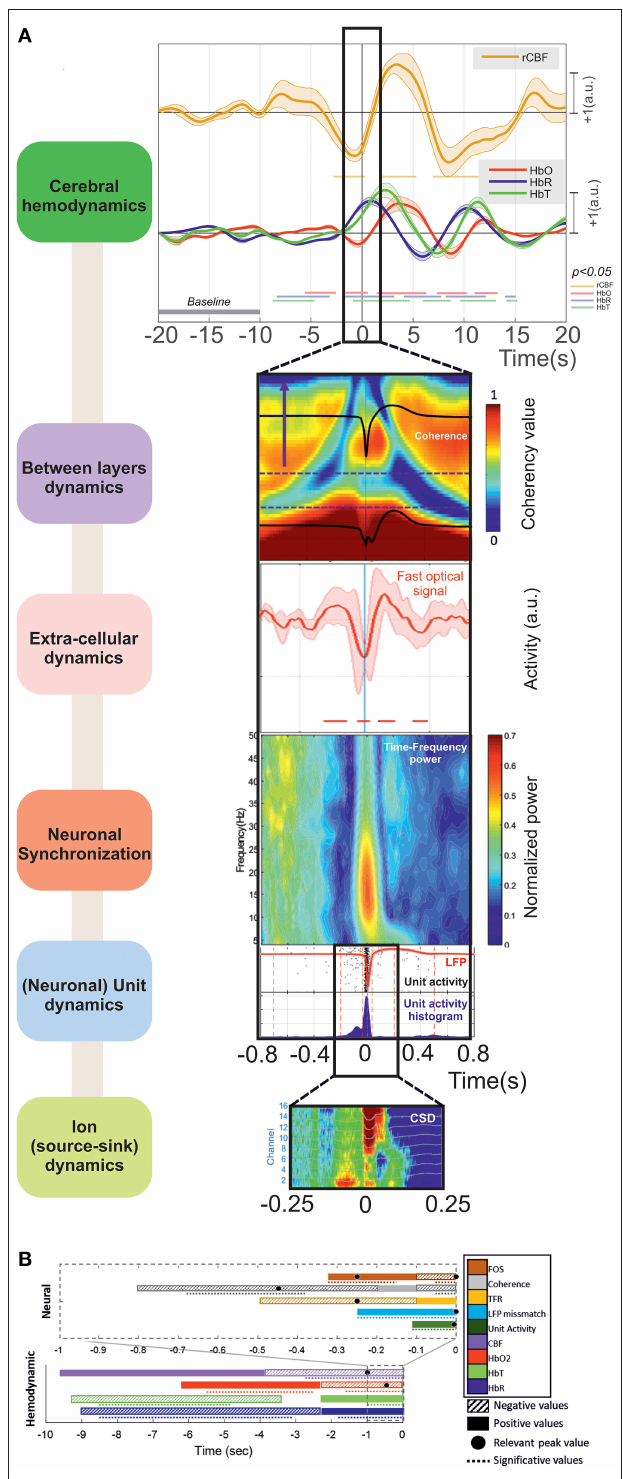
FIGURE 12 | (A) The main results can be summarized as (i) Cerebral hemodynamics : the hemoglobin concentration changes significantly from: − 8.5 ( ↓ [HbR] ↓ [HbT]) and − 5.5s ( ↑ [HbO 2 ]). Blood flow decreases significantly from − 2.5s (peak at − 1s). The hemoglobin concentration changes